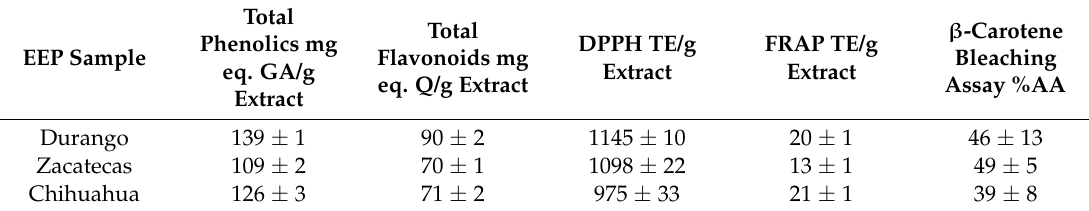
Table 1. Antioxidant Capacity of EEP